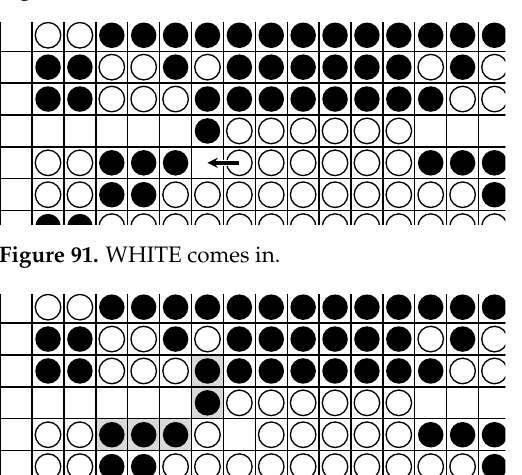
Figure 90. WHITE wins.